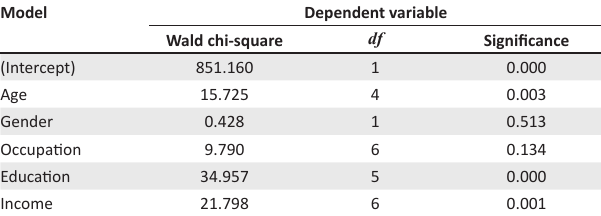
TABLE 5: Tests of model